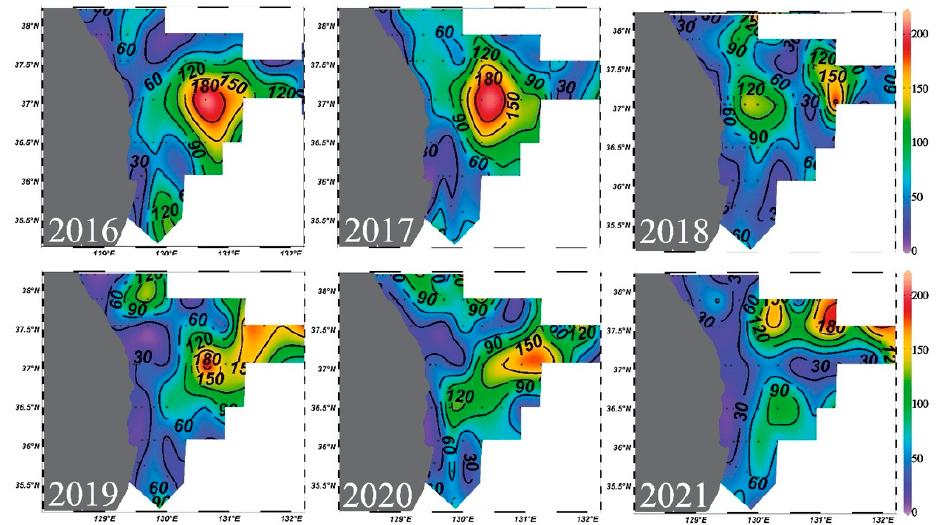
Figure 4. Inter-annual changes in horizontal distribution of mixed layer depth (MLD) (m) in the western part of East/Japan Sea (WES).